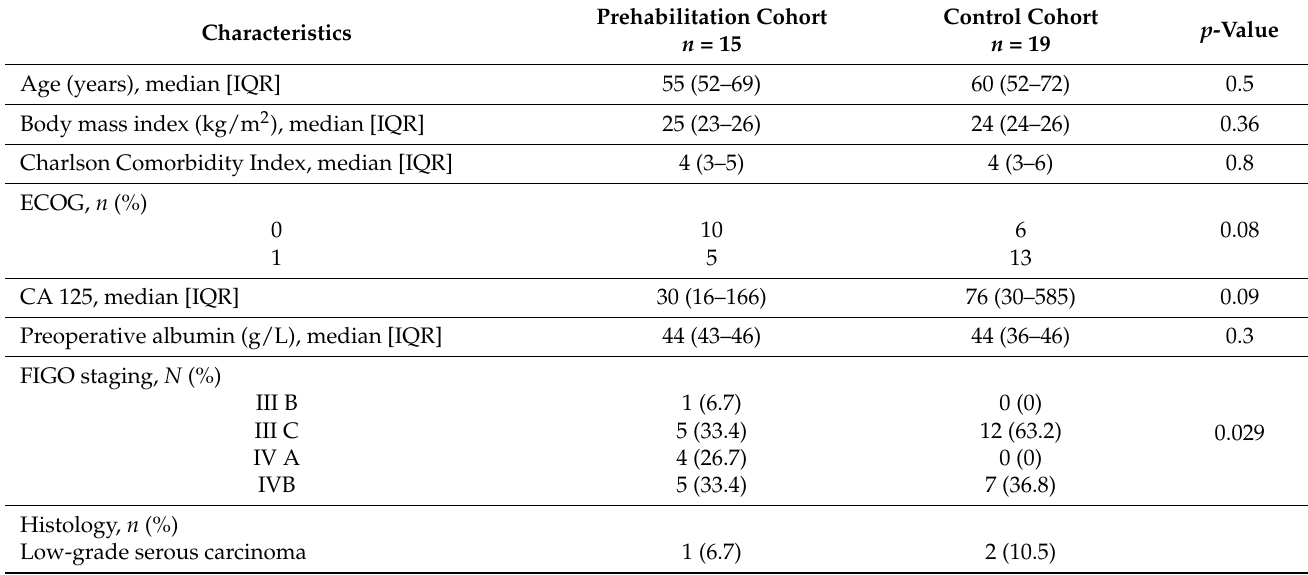
Table 1. Clinical and surgical characteristics of patients who underwent surgery for advanced ovarian cancer: multimodal prehabilitation vs. matched